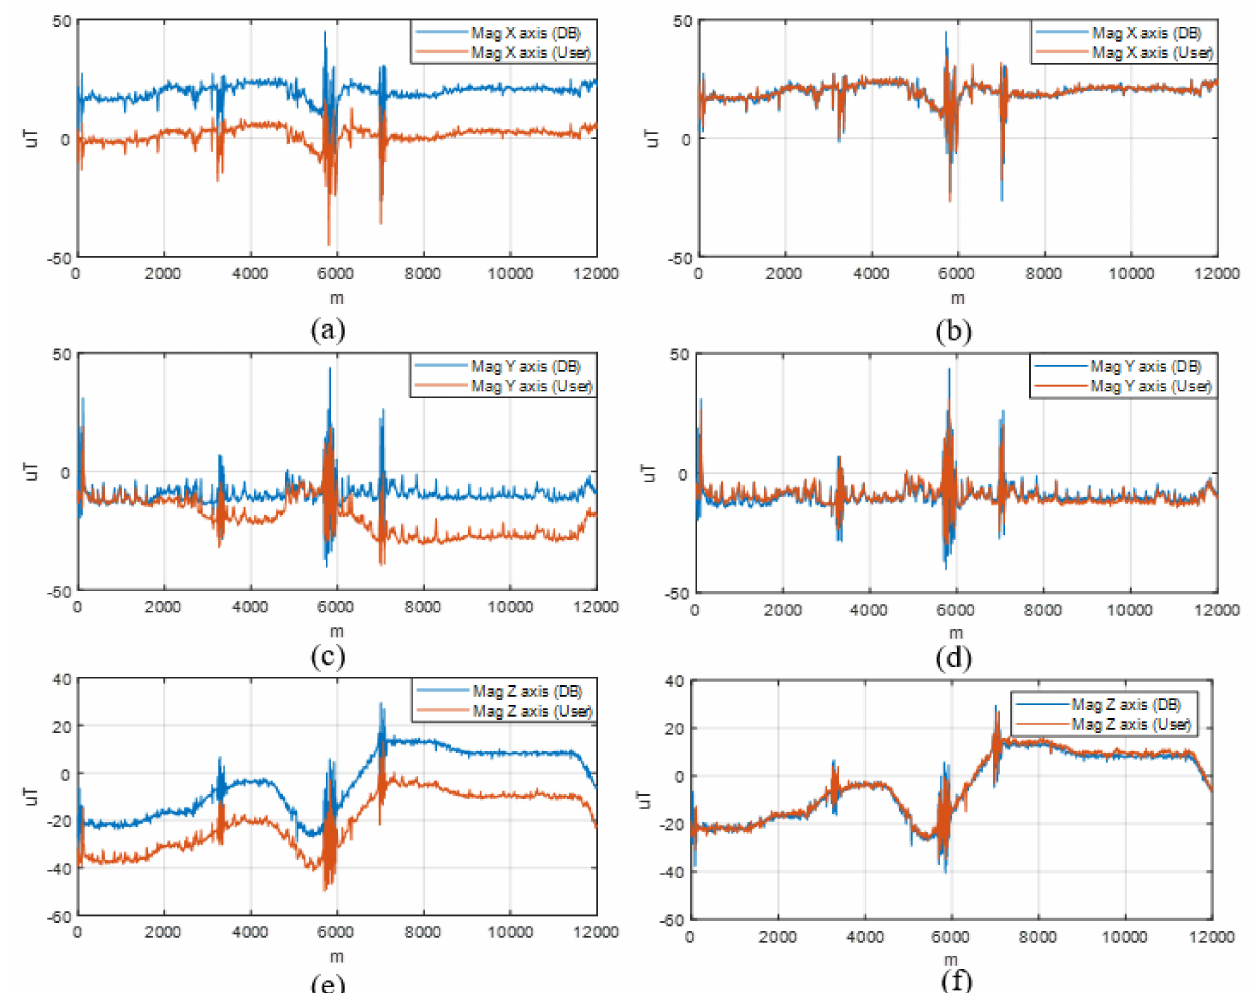
Figure 14. User data before and after applying axes transformation and calibration for scenario 4. Blue lines and red lines indicate the magnetic fingerprint DB data and user magnetic field data, respectively. ( a ) Before calibration of x axis. ( b ) After calibration of x axis. ( c ) Before calibration of y axis. ( d ) After calibration of y axis. ( e ) Before calibration of z axis. ( f ) After calibration of z